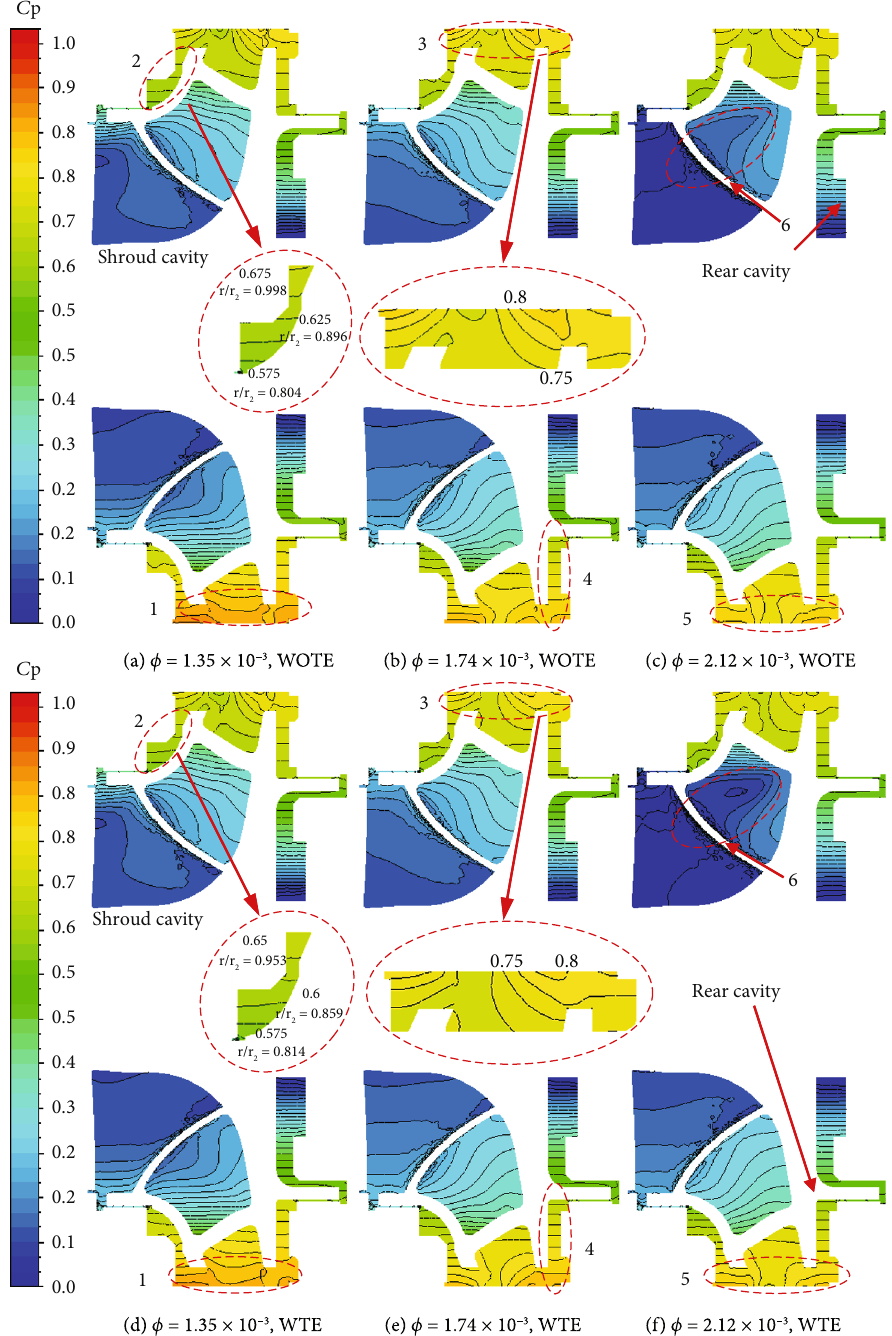
Figure 13: Comparison of the pressure fi eld with and without thermodynamic e ff